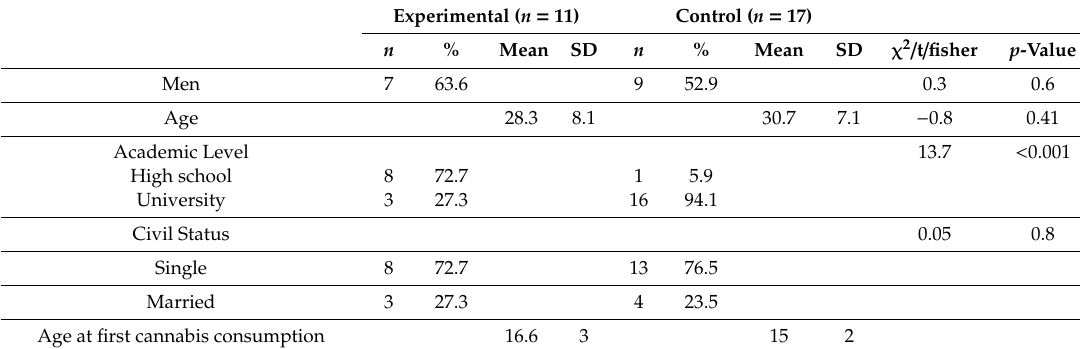
Table 1. Sociodemographic and clinical characteristics of the experimental (chronic cannabis users) and control